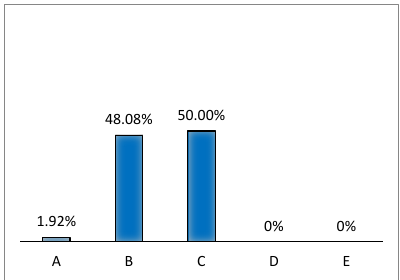
Figure 10. Was the amount of work appropriate considering the number of credits? A: absolute killer; B: too much; C: just right; D: too little; E: what work?.